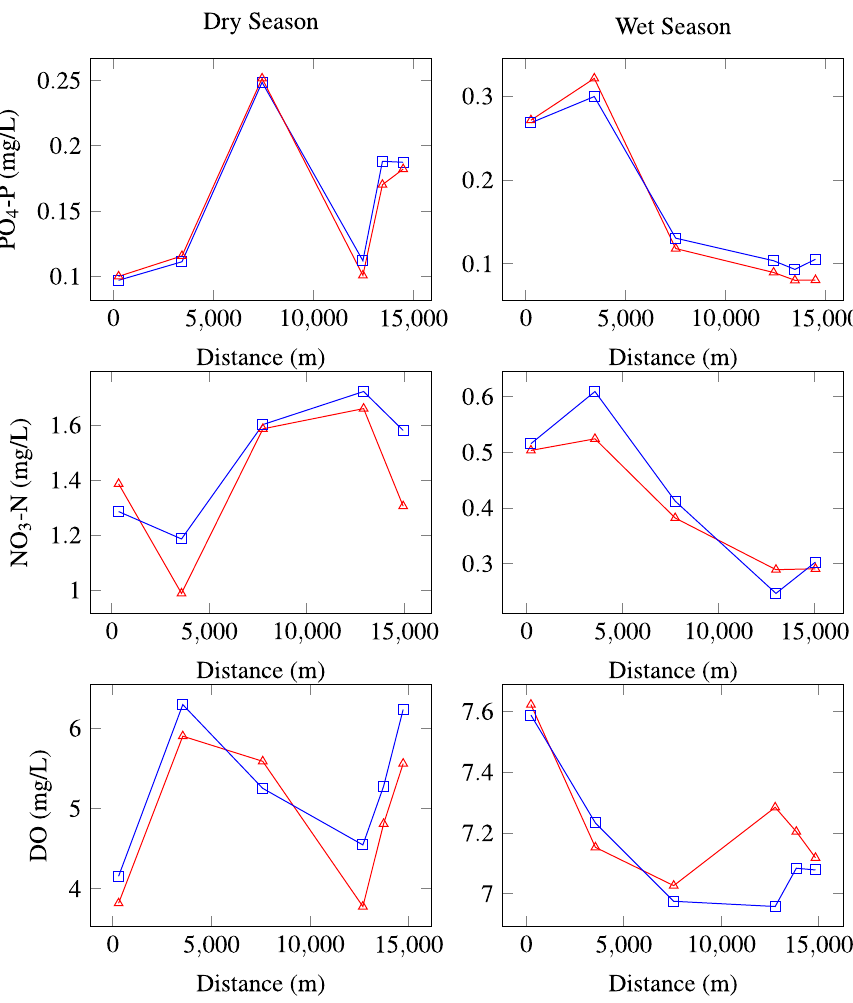
Figure 7. Comparison between the observed and simulated concentrations along the river for the scenarios S 1 and S 2 , squares represent the results of the simulations when the hydrodynamic is steady, triangles refer to the acquired data. The fit between observed and simulated values was used to validate the parameters used in the model, and to conclude that the simulations are correctly reproducing known conditions.